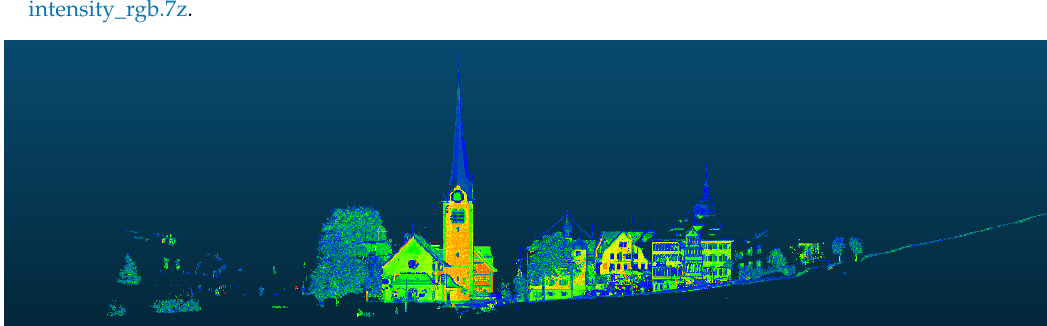
Figure 2. A point cloud visualization for the MEDIUM dataset from Semantic3D [63] representing Bildstein station. File: http://semantic3d.net/data/point-clouds/training1/bildstein_station1_xyz_ intensity_rgb.7z.